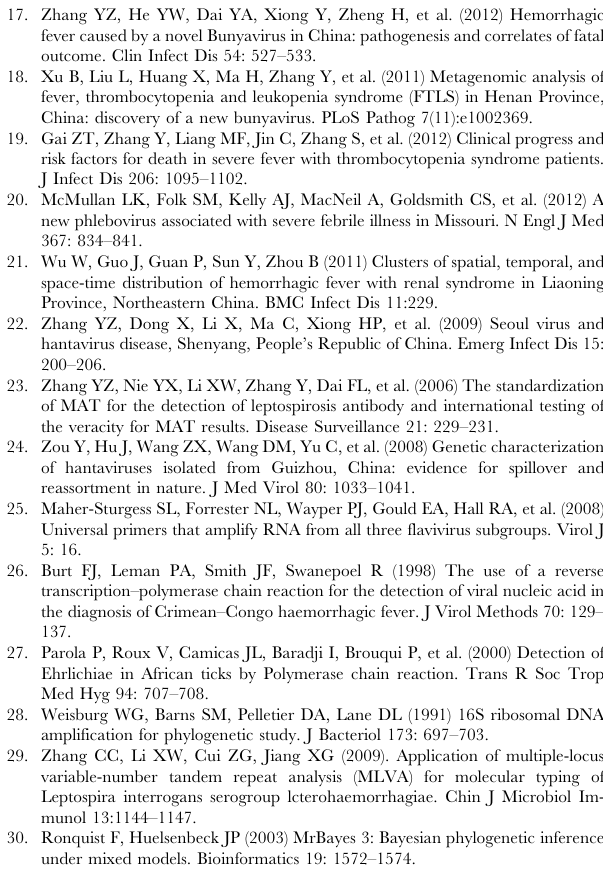
Figure S1 Map of Liaoning province showing the location of Dandong City.